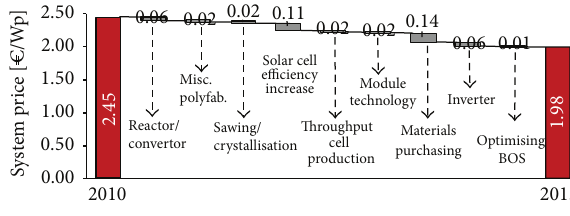
Figure 11: Reduction in photovoltaic system prices